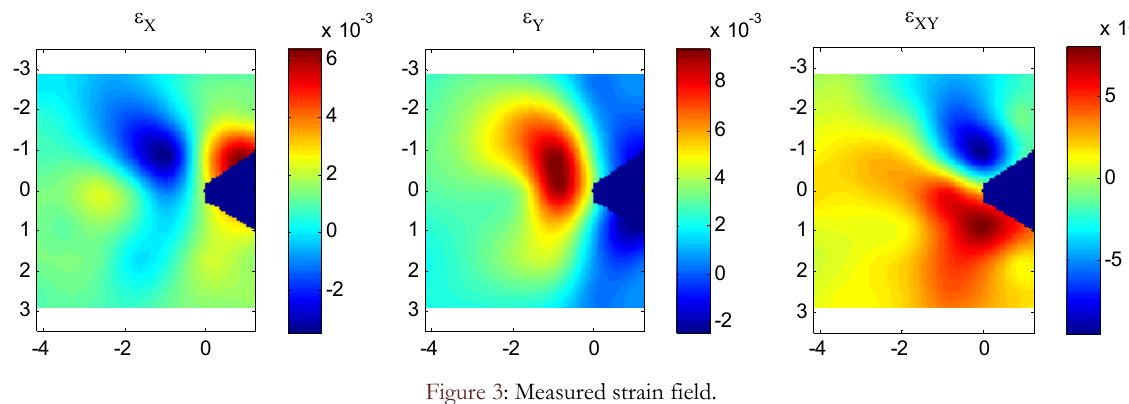
Figure 3: Measured strain field.